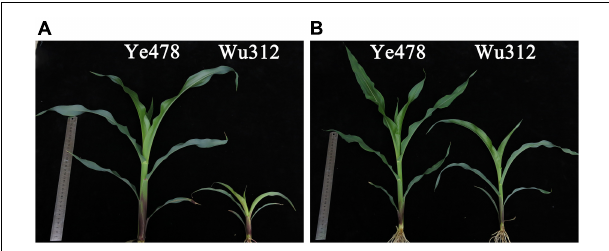
FIGURE 2 | The phenotypes of Ye478 and Wu312 under -Zn and CK conditions. In the -Zn (0.3 µ mol L − 1 Zn-EDTA) (A) and CK (10 µ mol L − 1 Zn-EDTA) (B) treatments, the maize inbred lines Ye478 (left) and Wu312 (right) were grown hydroponically for 21 days after transplanting. The representative shoots are displayed. Rulers of 30 cm length are shown in both (A,B)